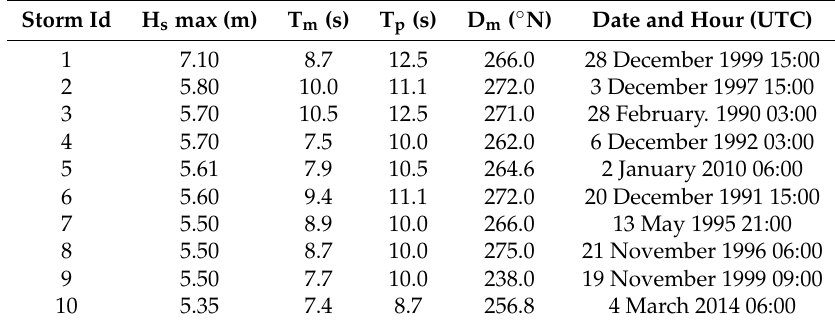
Figure 6. Offshore wave parameters (H s in ( a ), T m in ( b ), and D m in ( c )) recorded by the Ponza buoy during the years 1989–2014 with three-hourly time steps. The red color highlights the wave parameters associated with the highest waves (H s > 2 m). Table 2. Summary of the ten highest wave storm events recorded by the Ponza buoy in the period